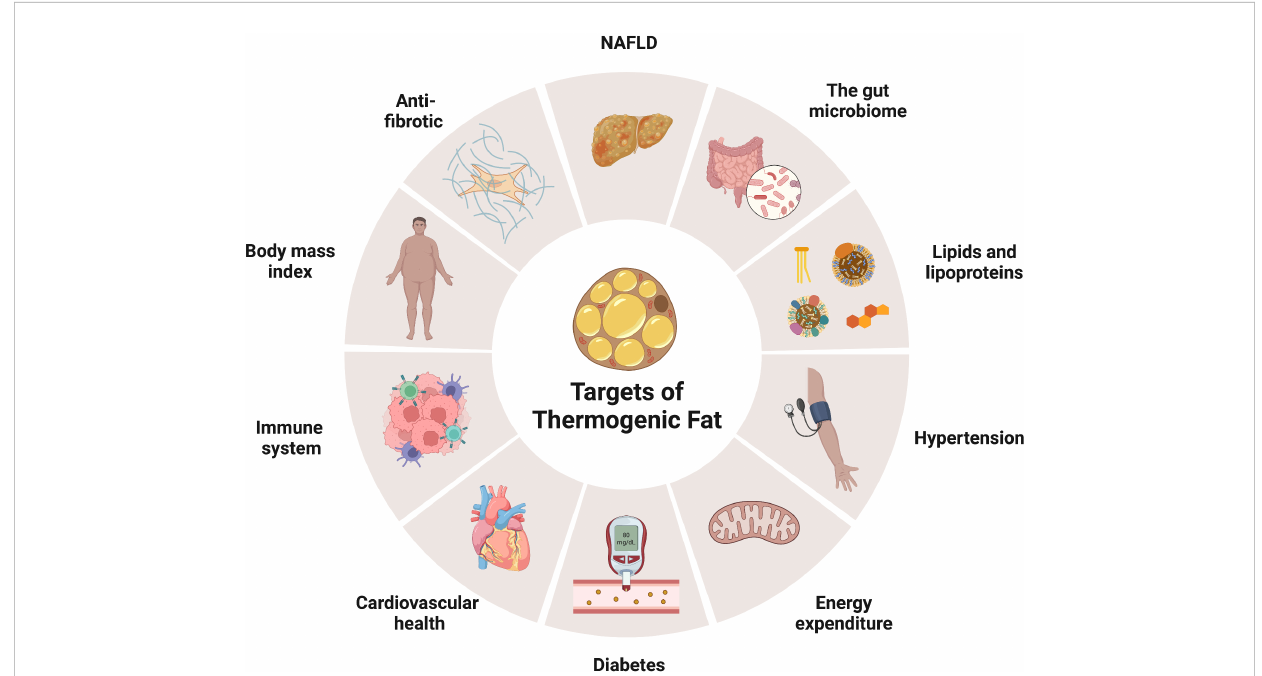
FIGURE 1 Metabolic hallmarks of thermogenic fat. Chronic overnutrition promotes adipose tissue malfunction, increasing the risk for developing metabolic diseases, such as type II diabetes, hypertension, fatty liver disease, and cardiometabolic disease, and premature death. Thermogenic fat (brown and beige) biogenesis and activation offers promising potential to improve systemic energy expenditure and ameliorate obesity and its associated comorbidities. Illustration created with